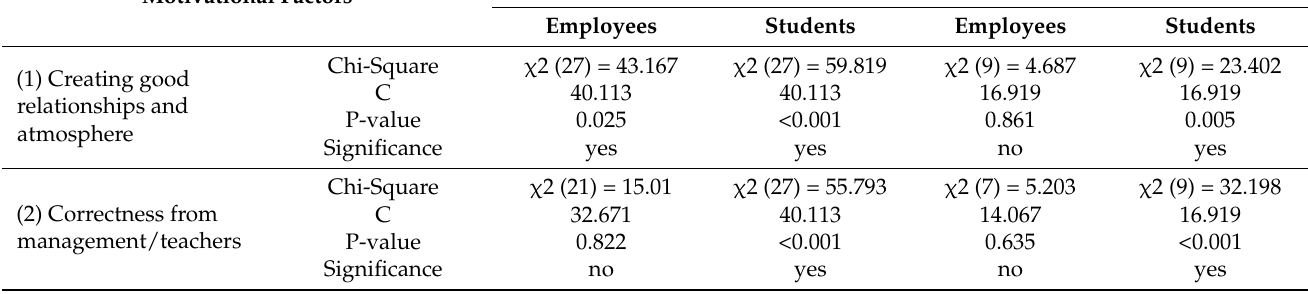
Table 3. Dependence between selected motivational factors and the level of teachers’ and students’ motivation (own